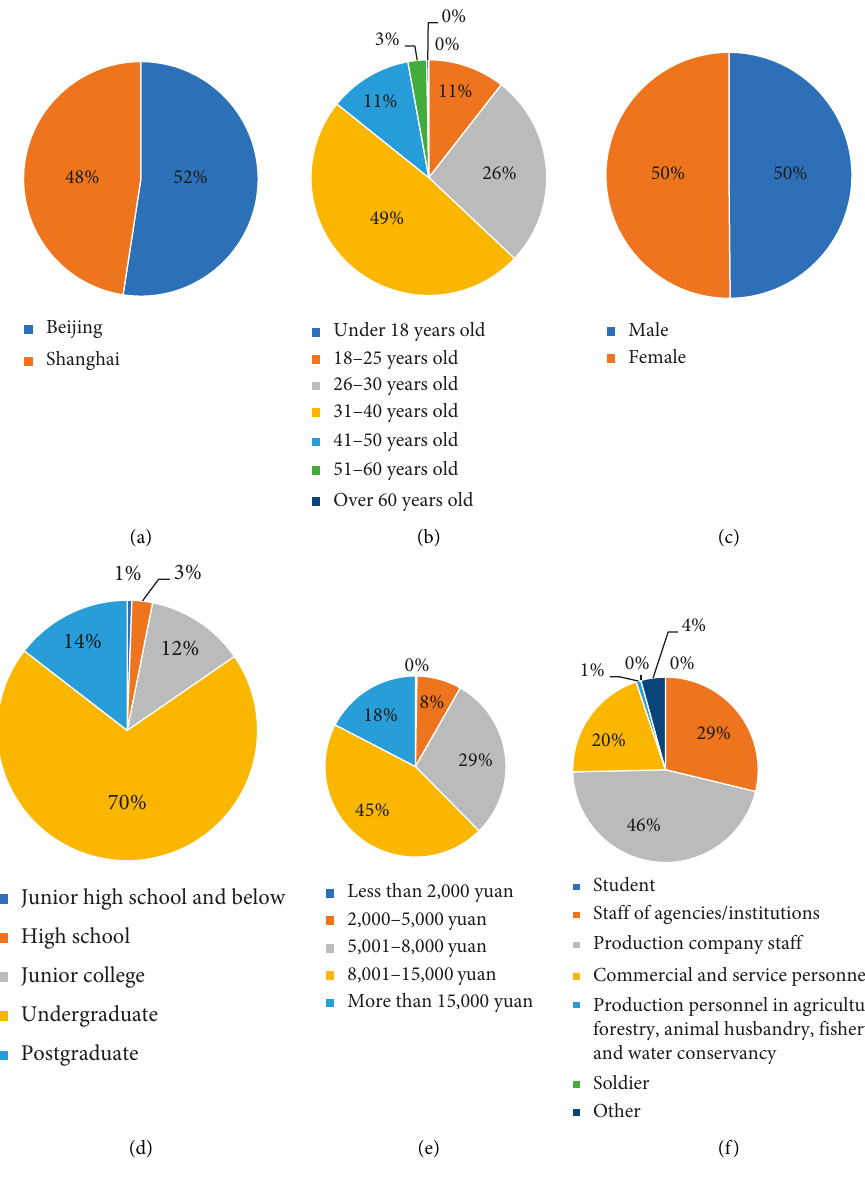
Figure 1: The distributions of respondents’ personal attributes. (a) City. (b) Age. (c) Gender. (d) Education level. (e) Monthly income after tax. (f)